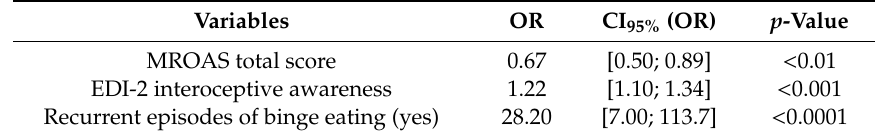
Table 5. Multiple logistic regression analysis (final model)—factors associated with “food addiction” ( N = 195). Variables OR CI 95% (OR) p -Value MROAS total score 0.67 Recurrent episodes of binge eating